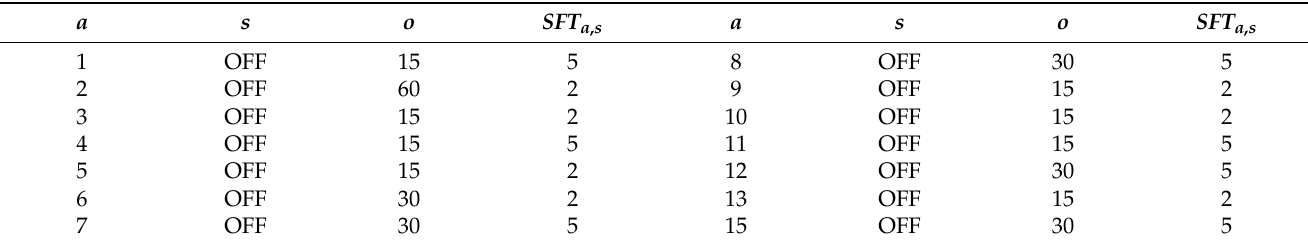
Table 3. Values of o and SFT a , s for events of turning the appliances off.